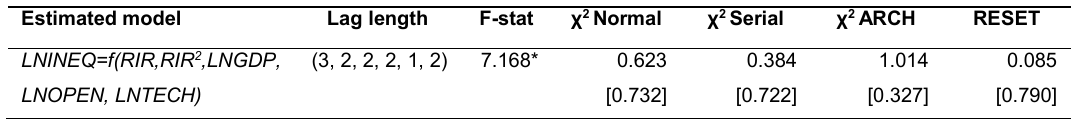
Table 4. ARDL cointegration test